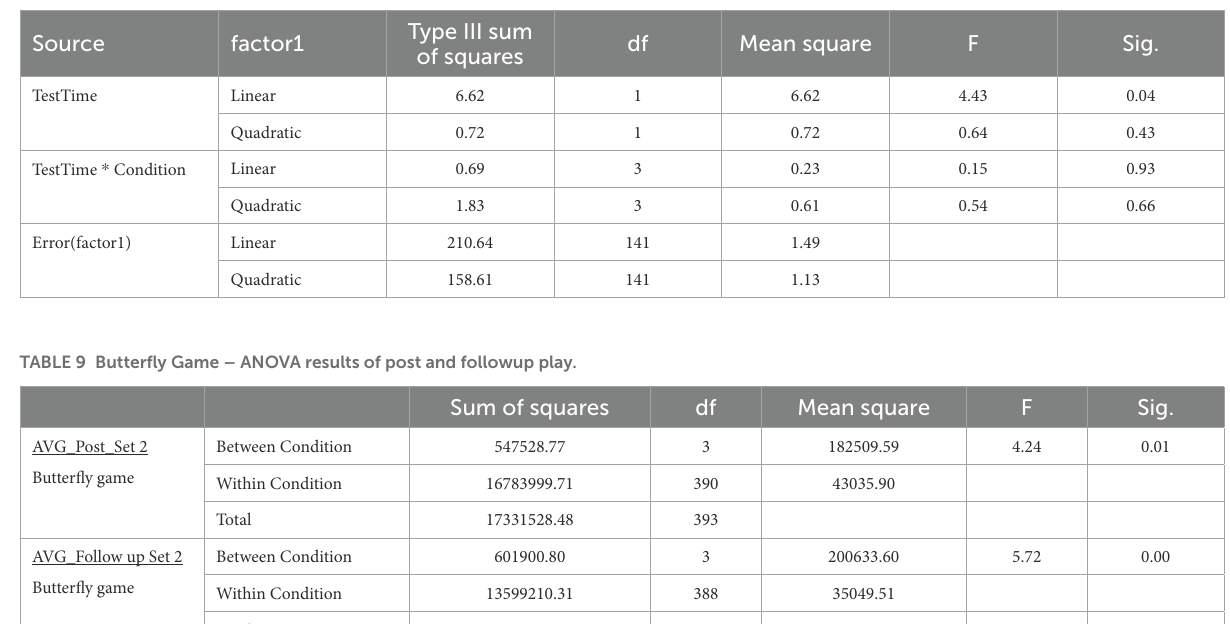
TABLE 8 GLM analyses for natural section science knowledge.